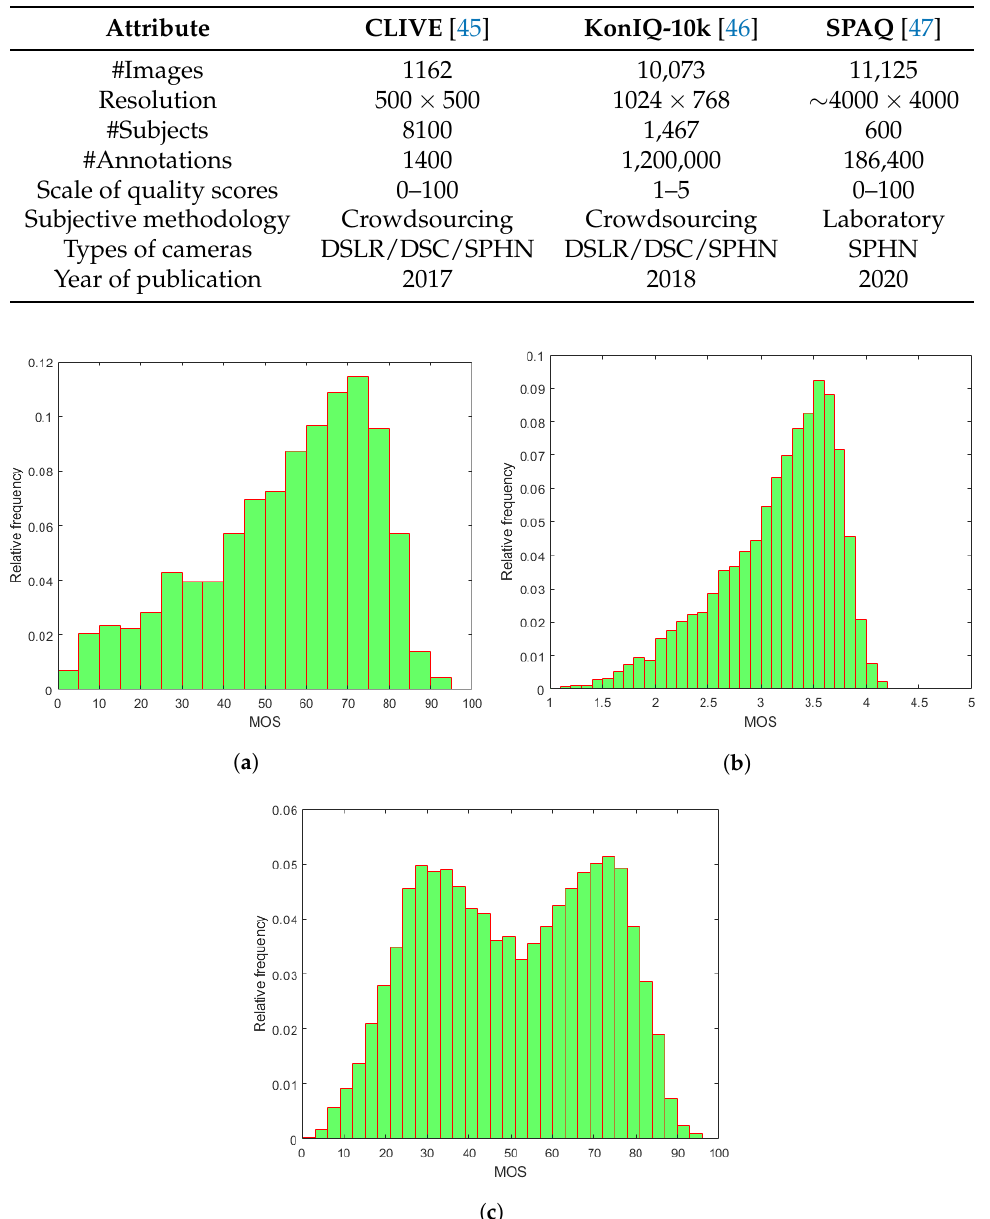
Figure 1. Empirical MOS distributions in the applied IQA databases: ( a ) CLIVE [45], ( b ) KonIQ- 10k [46], and ( c ) SPAQ